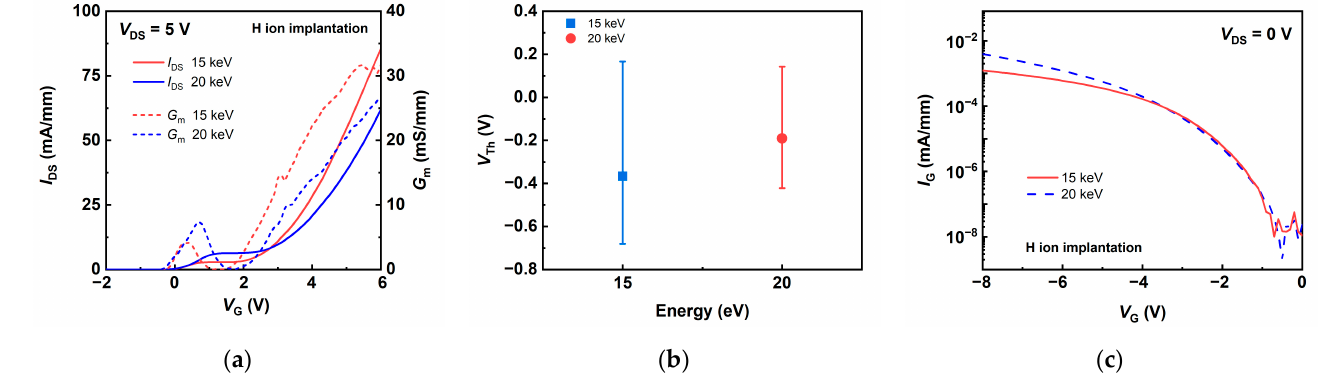
Figure 2. ( a ) Transfer characteristics; ( b ) average values and errors of threshold voltages; ( c ) gate leakage curves at the negative bias of p-GaN HEMTs with H ion implantation energies of 15 keV and 20 keV, without annealing.